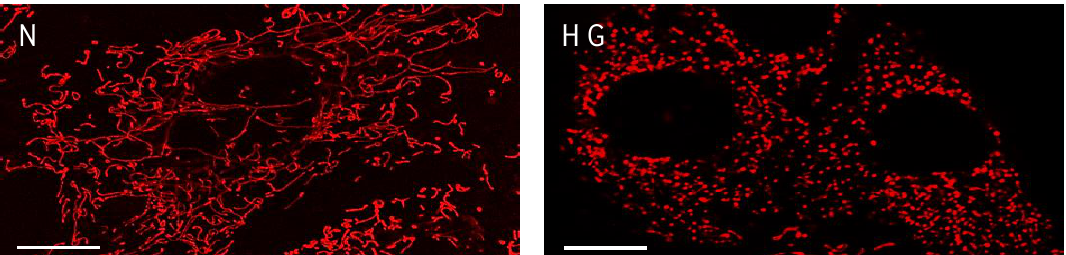
Figure 2. High glucose compromises mitochondrial morphology and promotes mitochondrial fragmentation. Representative confocal images of RRECs grown in normal (N) medium ( left ) stained with mitotracker red show long, tubular networks of mitochondria. In parallel, cells grown in high glucose (HG) medium ( right ) exhibit significant mitochondrial fragmentation. Scale bars: 10 µm.